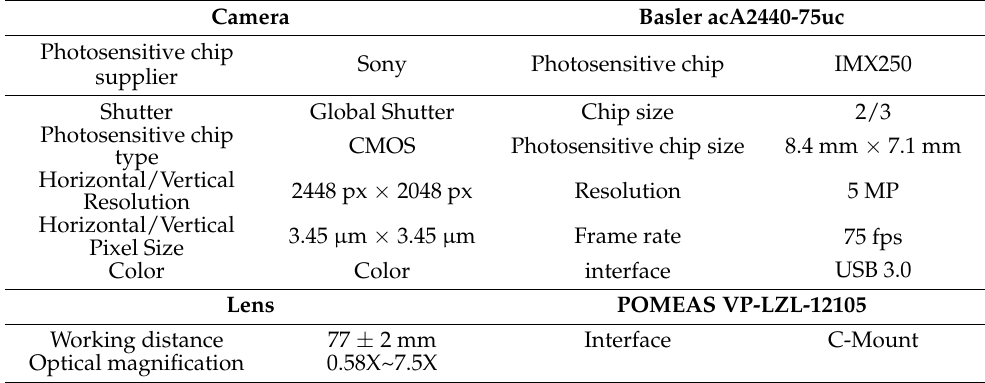
Table 2. Camera and lens parameters.